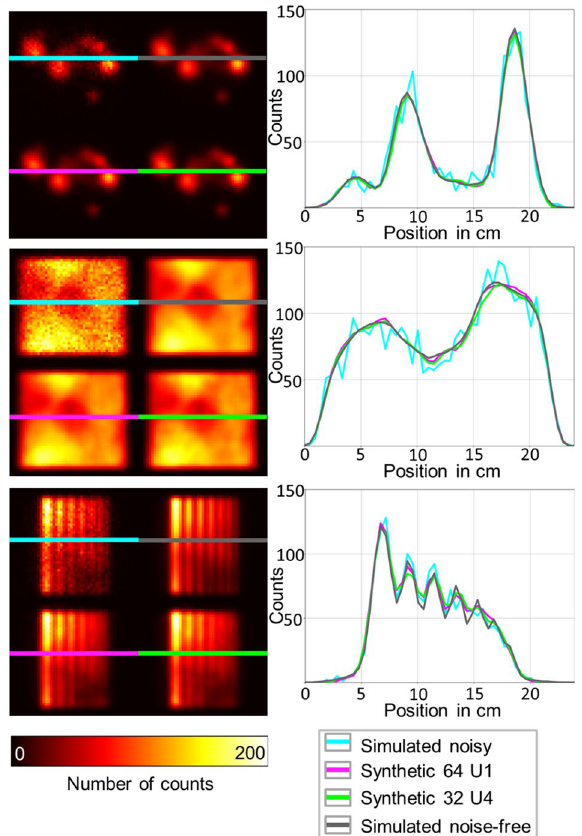
Fig. 6 Comparison of simulated noisy and noise‑free projections with synthetically generated projections. The synthetic projections were generated by u‑nets U1 (magenta) and U4 (green), respectively. From top to bottom, the projections of the following activity distributions are shown: random shape, hot Jaszczak with cold random shapes, stripe pattern. The graphs on the right show cross sections through the projections along the colored